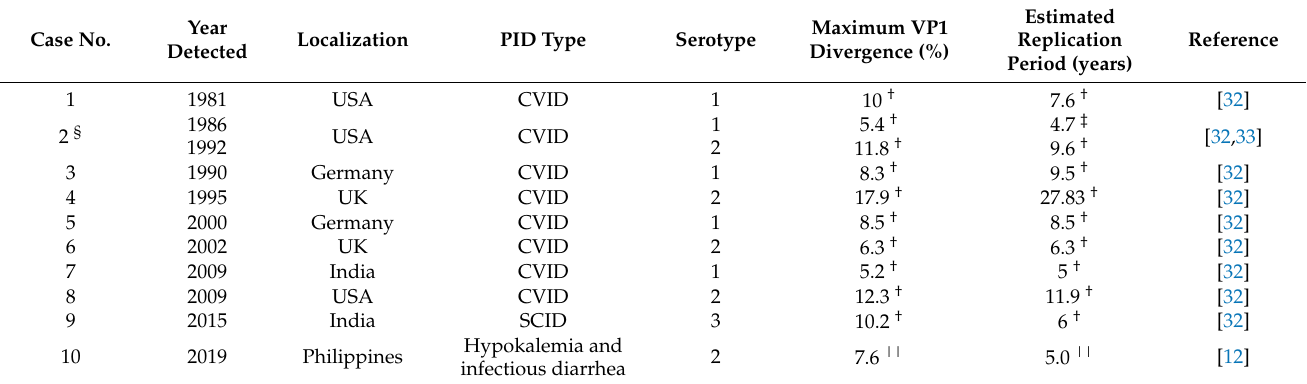
Table 1. Chronic iVDPV